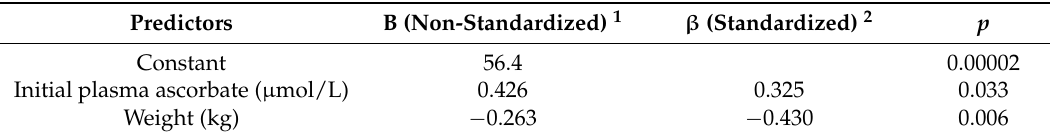
Table 3. Backward stepwise multiple linear regression analysis to determine independent predictors of plasma ascorbate concentration in the 50 mg/day